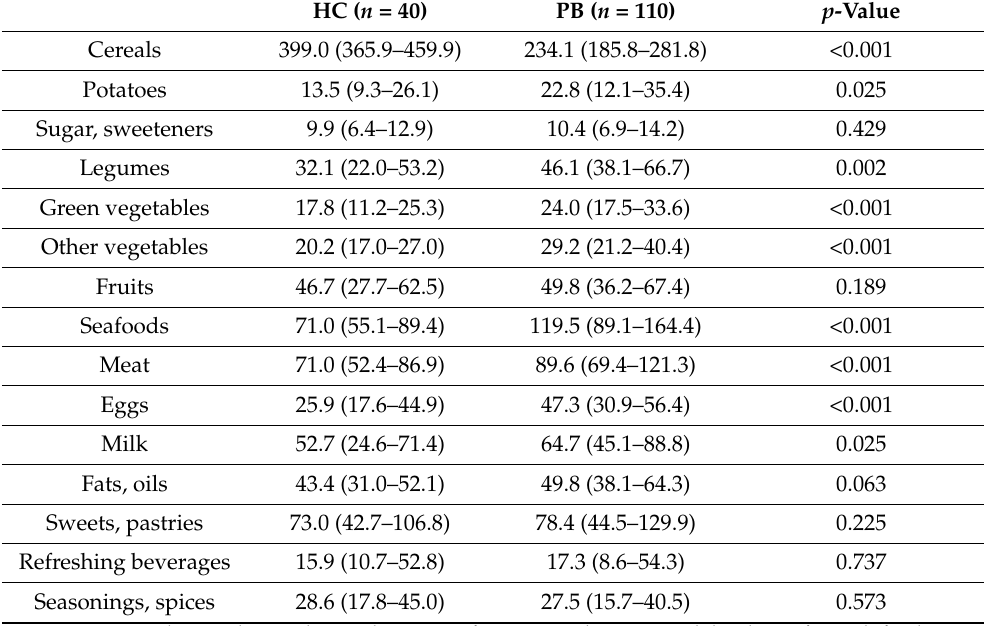
Table 5. Food group intake in the two dietary patterns of the Cohort A classified by discriminant analysis model.